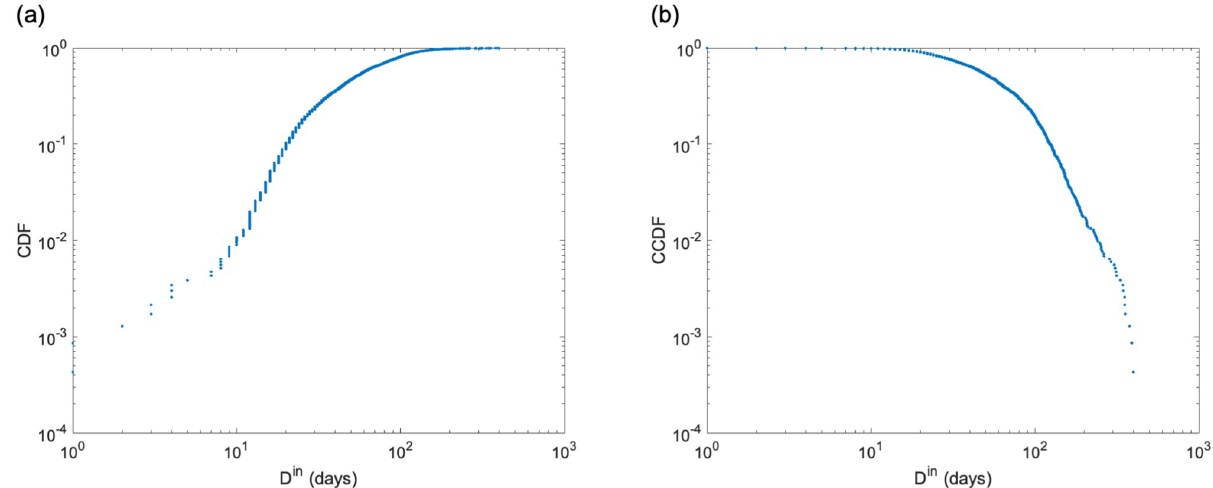
Fig 5. Distribution of duration of hospital stay D in . (a) Empirical cumulative distribution functions (CDF). (b) Empirical complementary cumulative distribution functions (CCDF). In the logarithmic plot, both tails are straight, which are similar to a power law distribution.